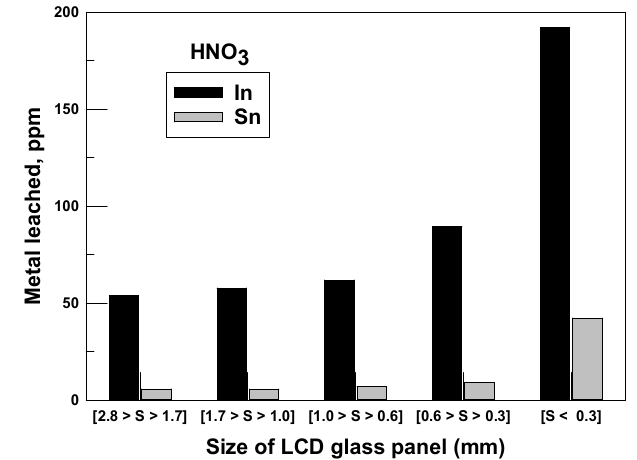
Figure 4. Leaching behavior of indium and tin as a function of the size of the cullet pieces, as classified by sieving using 5 M HNO 3 as the lixiviant.